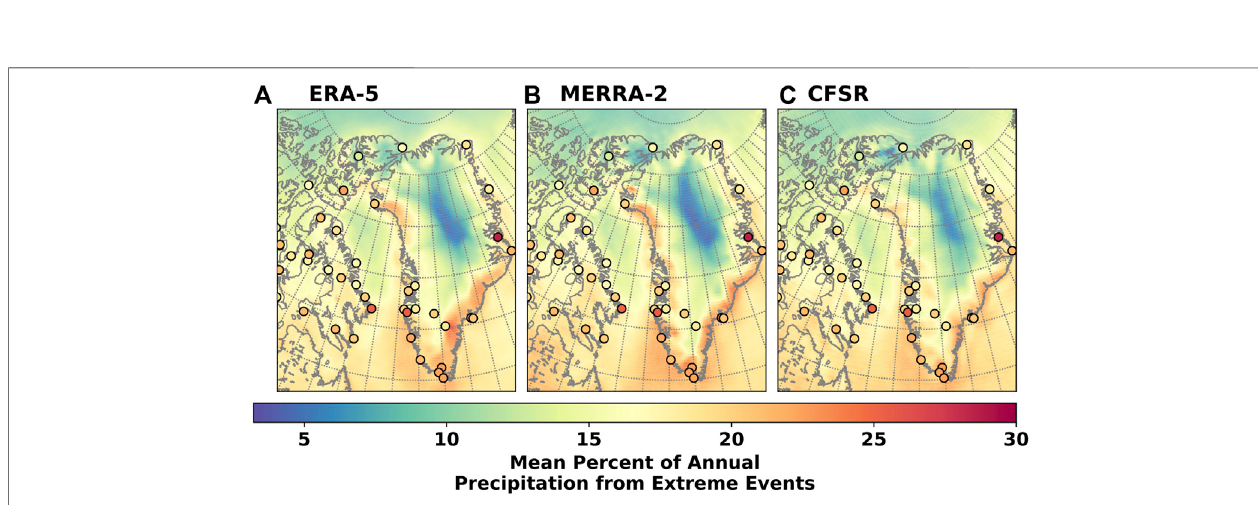
FIGURE 4 | Mean percent of annual precipitation attributed to extreme events based on (A) ERA-5, (B) MERRA-2, and (C) CFSR. Circles show the relative contribution of extremes to annual precipitation for each station with at least 4 years of data.